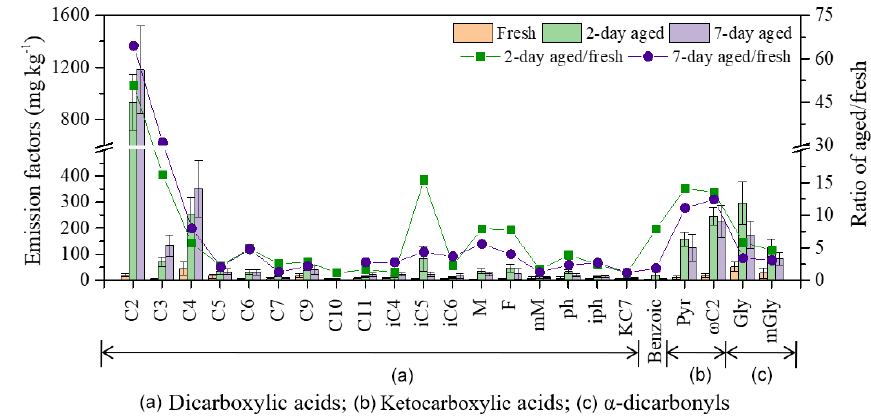
Figure 3. Average emission factors of dicarboxylic acids and related compounds from biomass burning experiment for the fresh, 2 and 7d aged PM 2 . 5 aerosols. The squares and dots denote the ratios of aged to fresh ( A/F ) emission samples for the dicarboxylic acids and related compounds after 2 and 7d